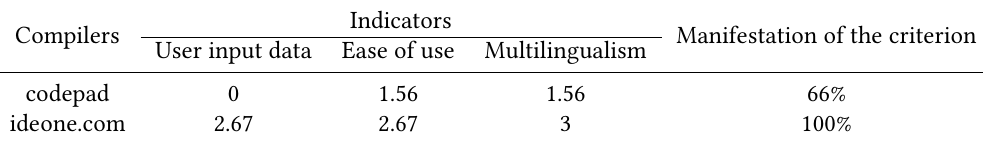
Table 2 Functional criterion for web-oriented compilers and its